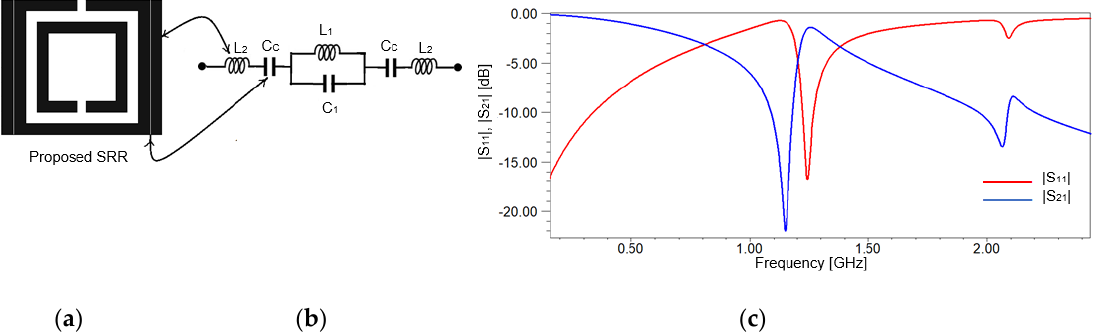
Figure 2. Proposed SRR: ( a ) SRR with vertical strips, placed at the distance s from the initial SRR in Figure 1a; ( b ) equivalent circuit; ( c ) frequency response of the scattering parameters for proposed SRR. Table 1. Dimensions of the SRR in Figure 1a or Figure 2a.